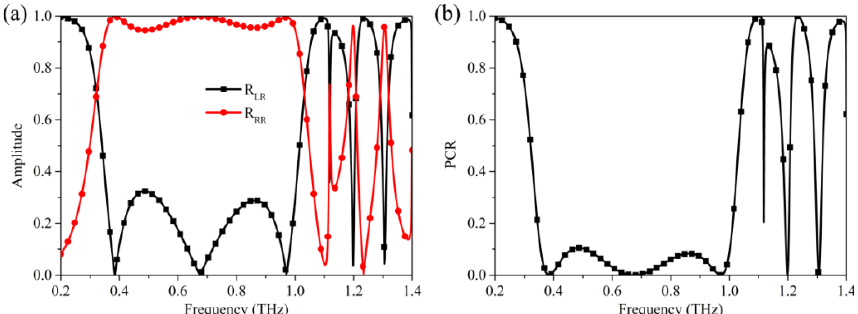
Figure 5. ( a ) The reflection spectra and ( b ) polarization conversion efficiency for the incident right- circularly polarized wave.